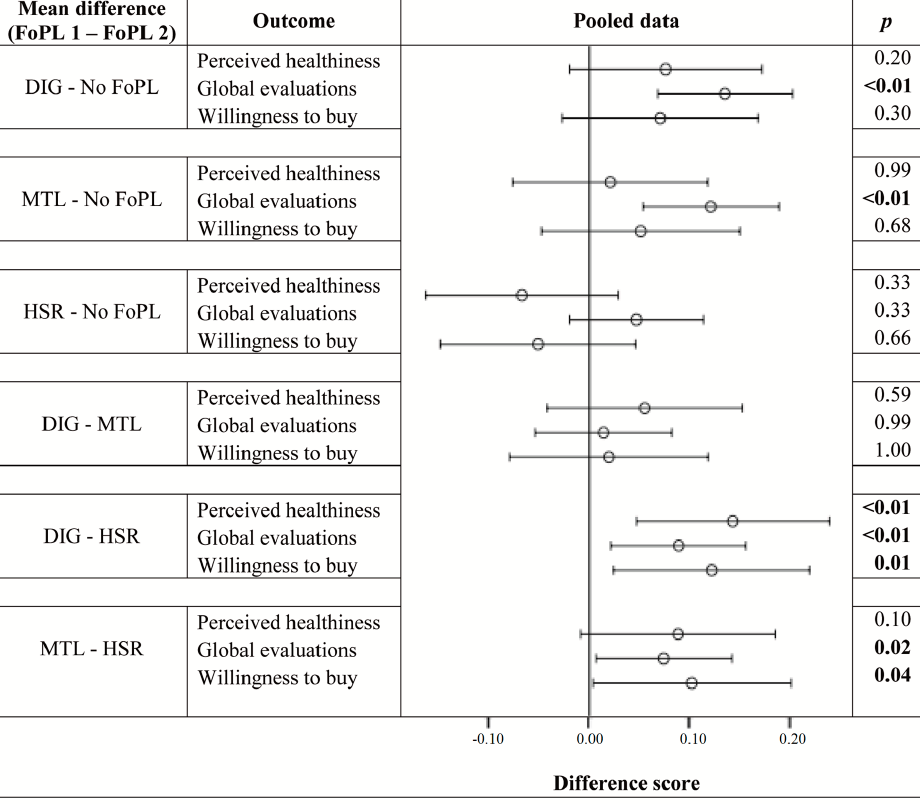
Figure 2. Difference in ratings between FoPLs ( (cid:9) ) and the upper ( (cid:96) ) and lower ( (cid:97) ) bounds of 95% confidence intervals for perceived healthiness, global evaluations and willingness to buy for pooled